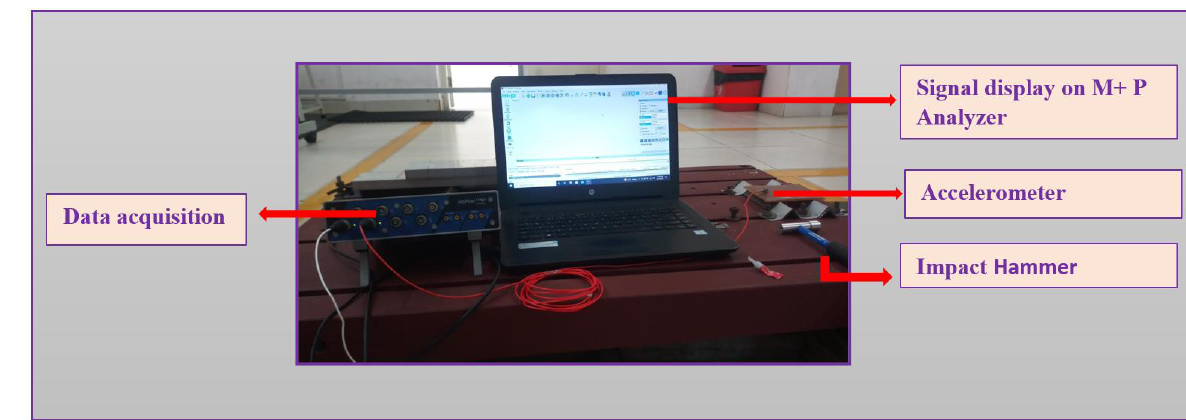
Figure 5. Sample setup for impulsive excitation of vibration.